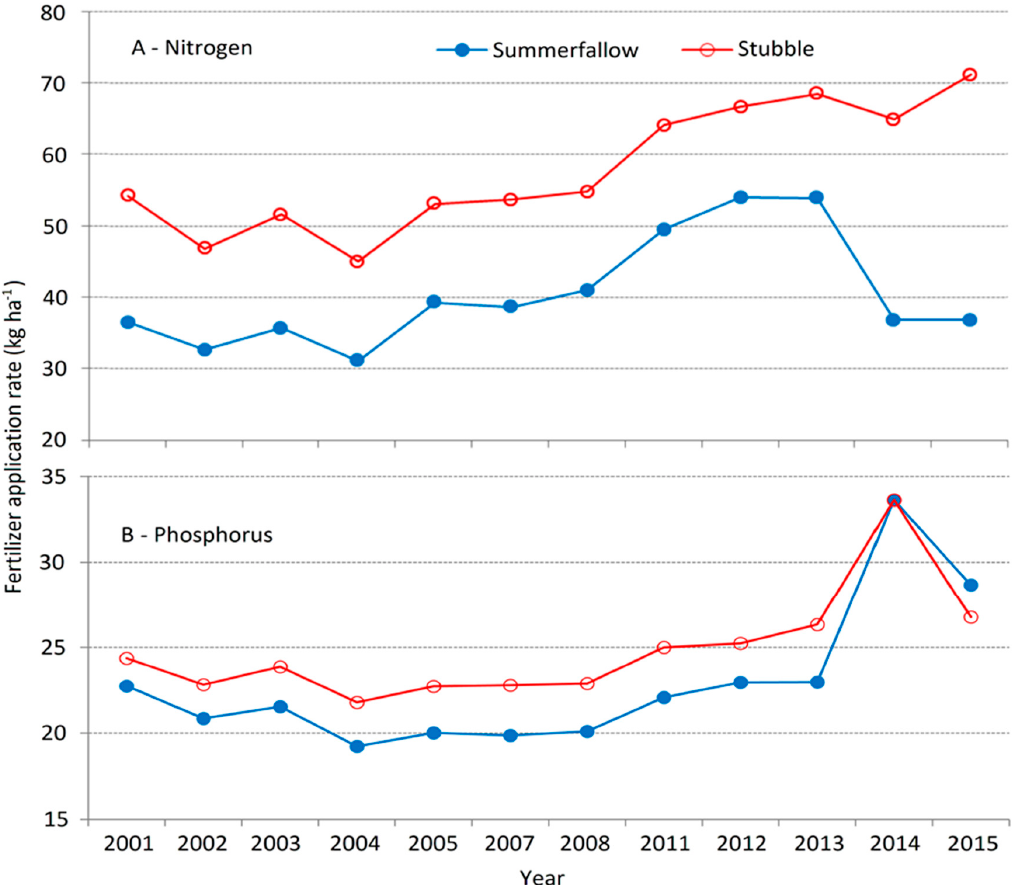
Figure 6. Nitrogen (N) and phosphorus (P) fertilizers used for durum wheat grown on summerfallow versus on stubble fields in Saskatchewan during 2001–2015 (Source: Saskatchewan Crop Insurance Corporation, n = 8657 individual durum wheat growers (2001–2013) and Saskatchewan Crop Planning Guide in